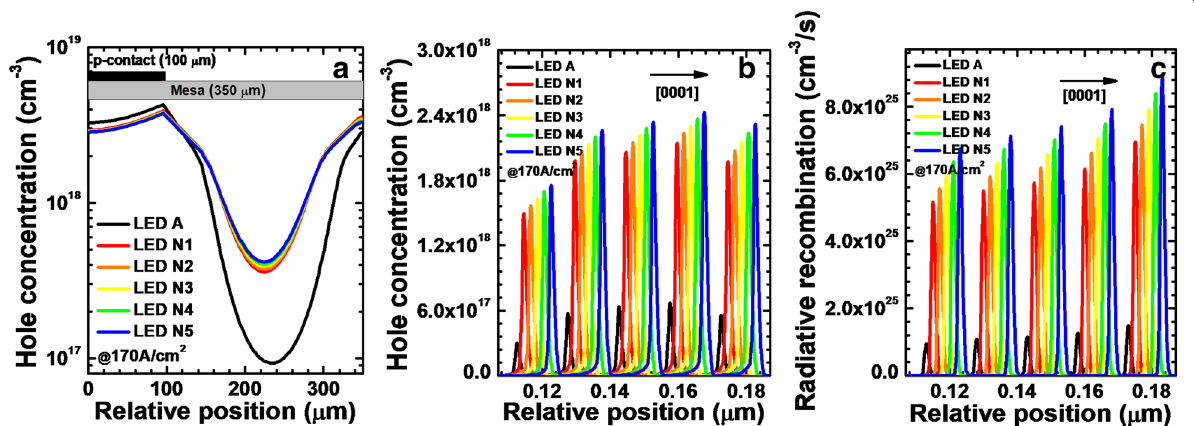
Fig. 15 a Horizontal hole concentration in the LQW, b hole concentration, and c radiative recombination profiles in the MQWs for LEDs A and N i ( i = 1, 2, 3, 4, and 5) when the current density is 170 A/cm 2 . We purposely shift the curves for b and c by 2 nm for easier